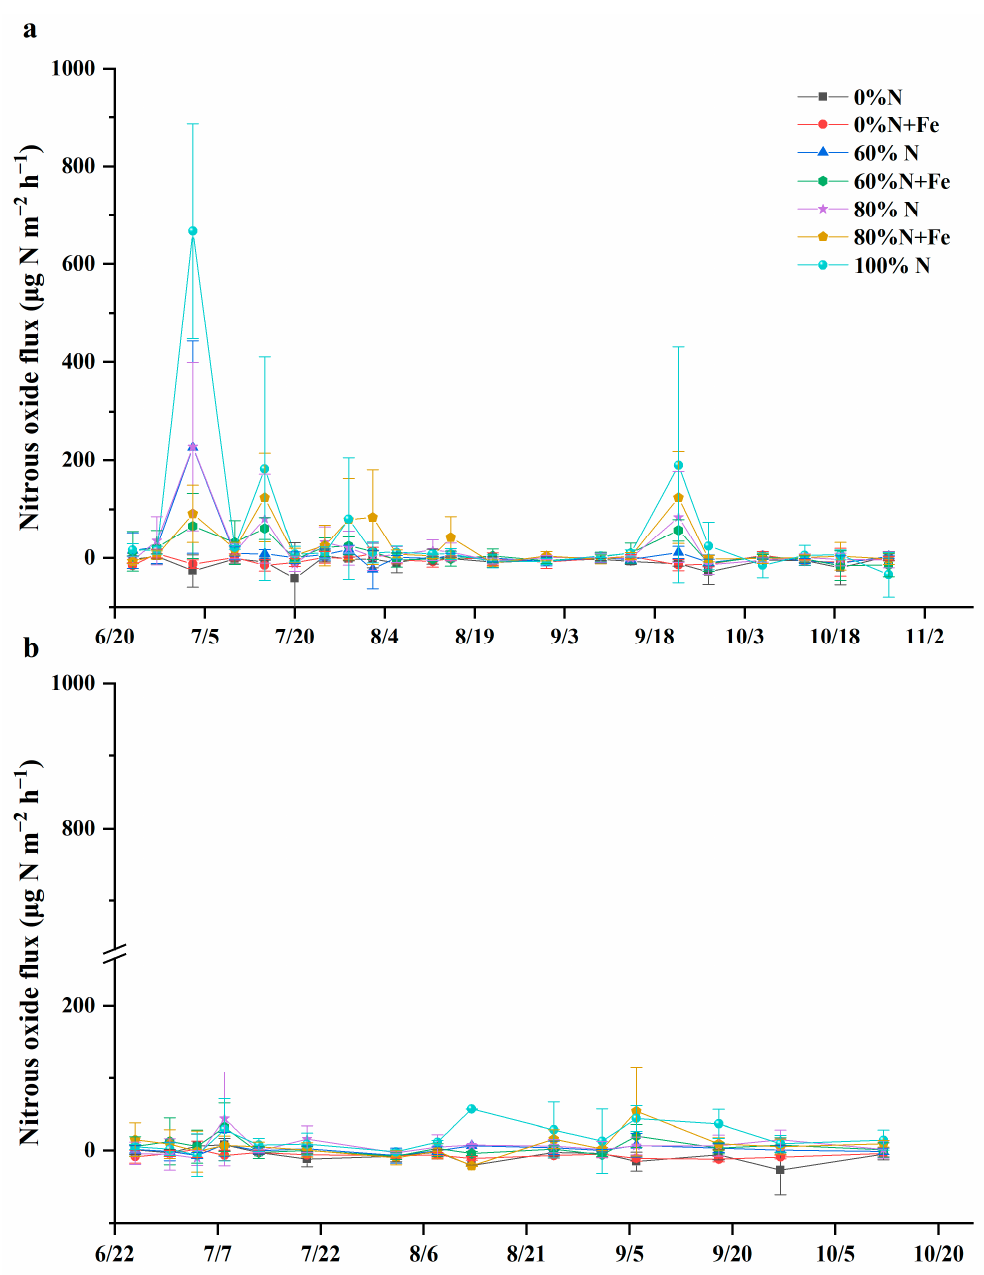
Figure 4. Nitrous oxide flux from a paddy under various nitrogen fertilization rates with or without iron amendment in 2019 ( a ) and 2020 ( b ). The conventional N fertilization rate (315 kg N hm − 2 season − 1 ) for rice in the lower Yangtze River Delta is 100%N. Fe was applied at 5000 kg hm − 2 as iron powder (>99% purity) when the field experiment was initiated.